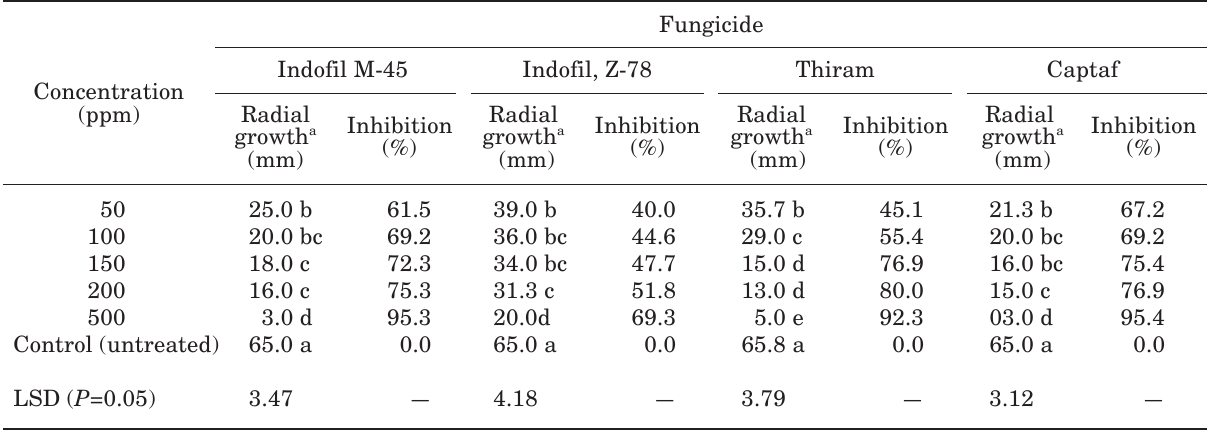
Table 1. Evaluation of non-systemic fungicides in vitro on radial growth of Alternaria brassicae on